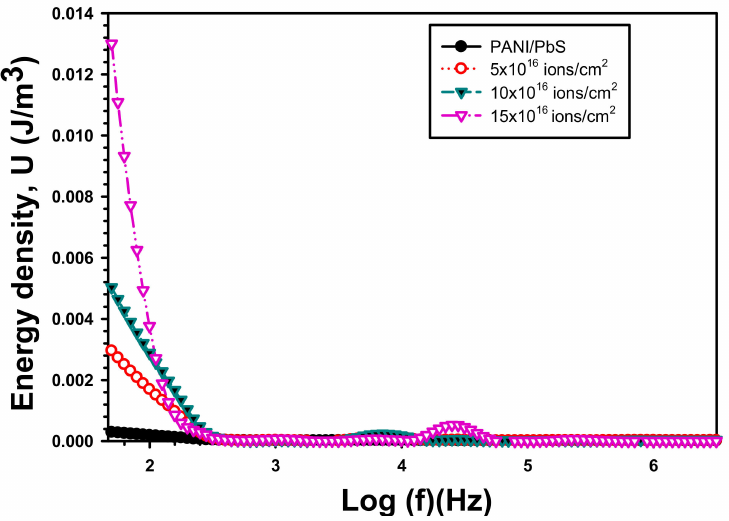
Figure 12. Energy density U with frequency for pristine and treated PANI/PbS